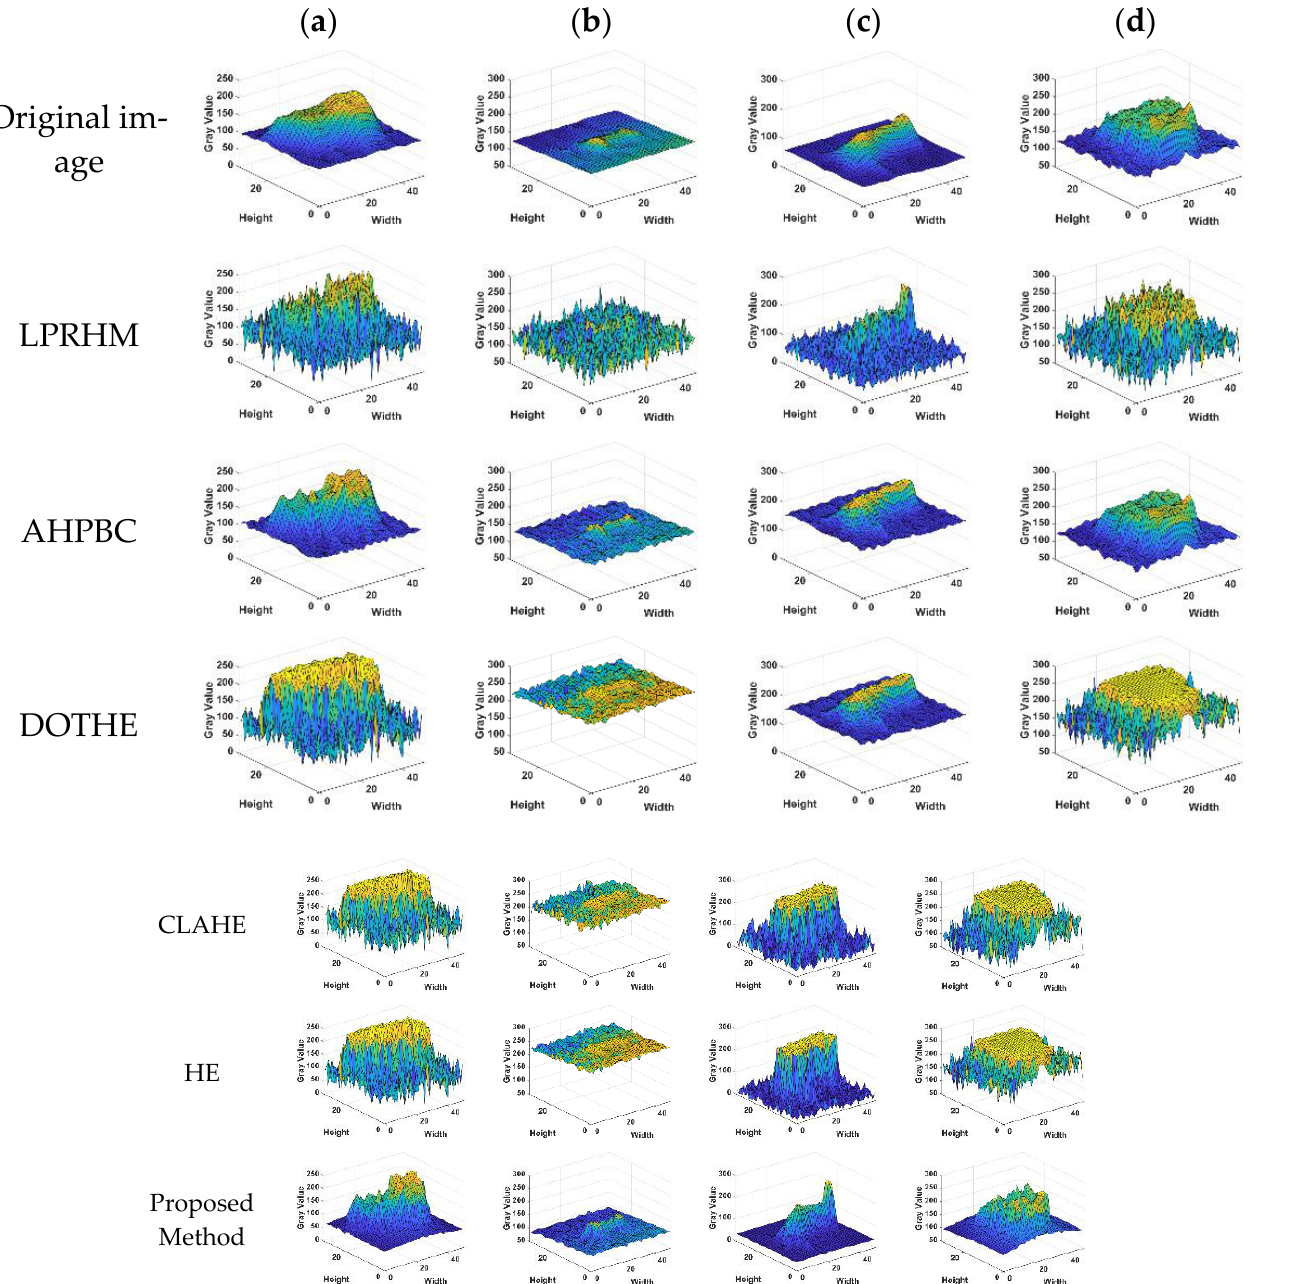
improved, and the background noise around the target is also suppressed, which shows that the detection effect of the target in this method is the best.